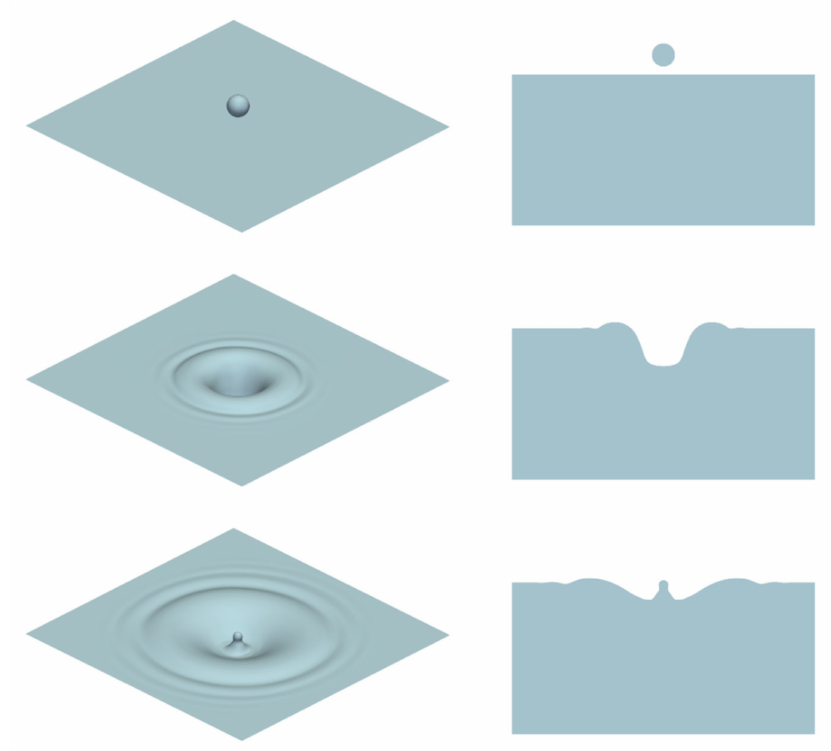
Figure 2. Examples of frames (3D and 2D used to extract the crater depth) showing the evolution of the craters and of the free surface of the pool for a case of single drop impact, impact velocity 1.4 m/s.